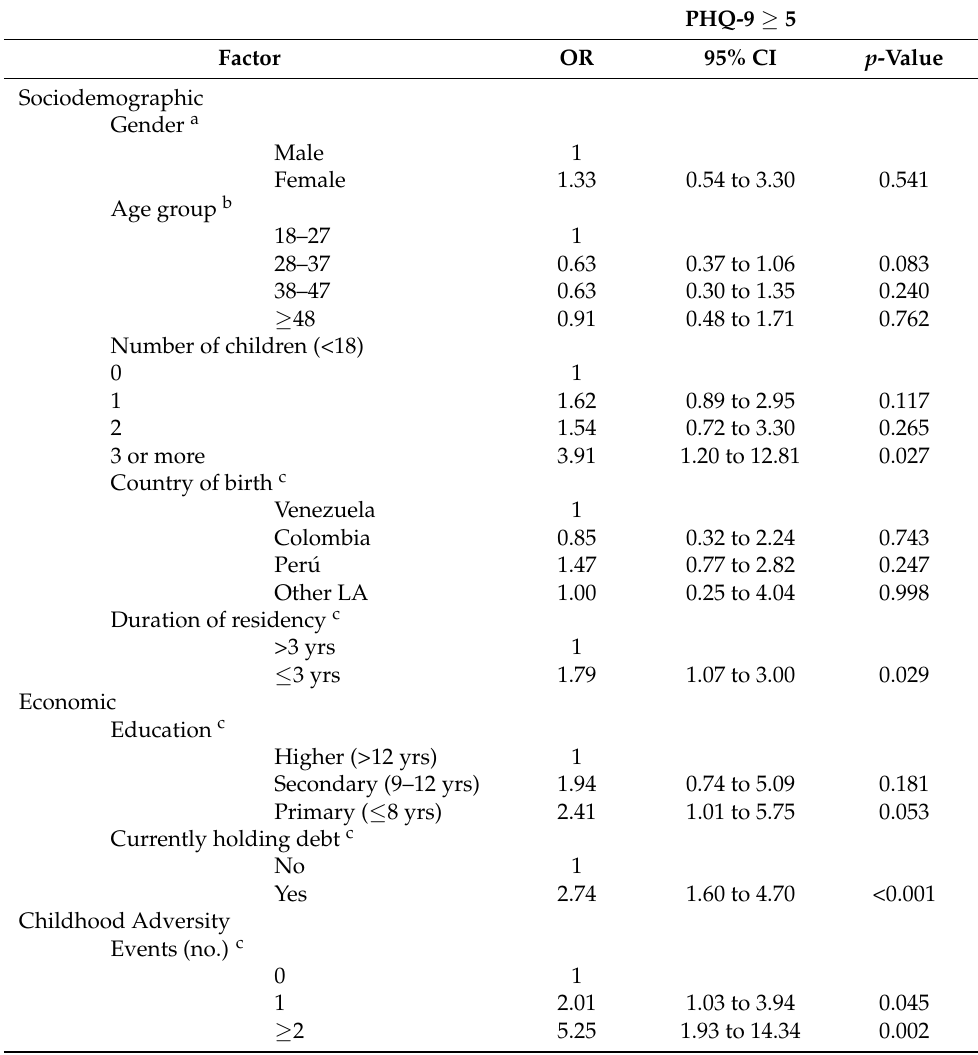
Table 4. Variables independently associated with PHQ-9 ≥ 5 with respective adjusted odds ratios, 95% confidence intervals, and p -values. PHQ-9 ≥ 5 Factor OR 95% CI p